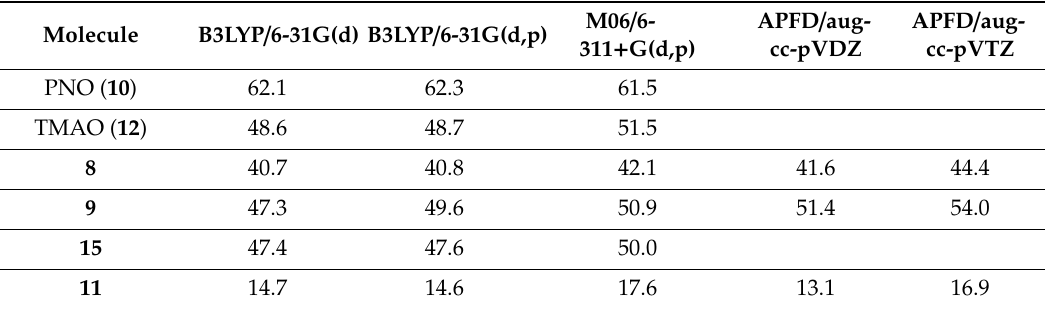
Table 3. Calculated bond dissociation enthalpies (BDE, kcal / mol; 1.000 kcal = 4.184 kJ) for selected N -oxides including pyridine N -oxide (PNO, 10 ) and trimethylamine N -oxide ( 12 , TMAO). For the BDE values for N -methylazepine N -oxide ( 8 → 6 ) and its 7-azanorcaradiene valence isomer ( 9 → 7 ), the lowest enthalpy values were employed for each stereoisomeric pair (e.g., 6a vs. 6b ). M06 / Molecule B3LYP / 6-31G(d) B3LYP / 6-31G(d,p)